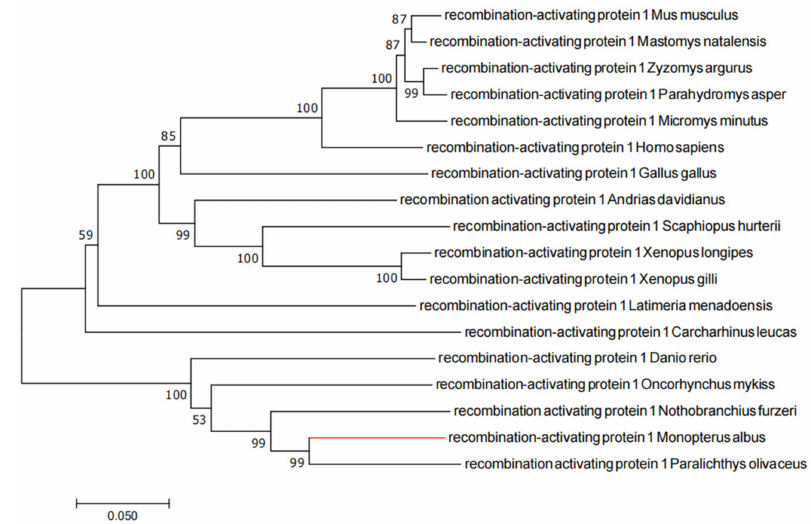
Figure 1. Phylogenetic tree of RAG1 proteins. The phylogenetic tree was constructed based on the full-length amino acid sequences by the maximum likelihood (ML) method, and the bootstrap value was set at 1000. GenBank accession numbers: Mus musculus (NP_033045); Mastomys natalensis (ACA47349); Zyzomys argurus (ACA47369); Parahydromys asper (ACA47358); Micromys minutus (ACA47353);